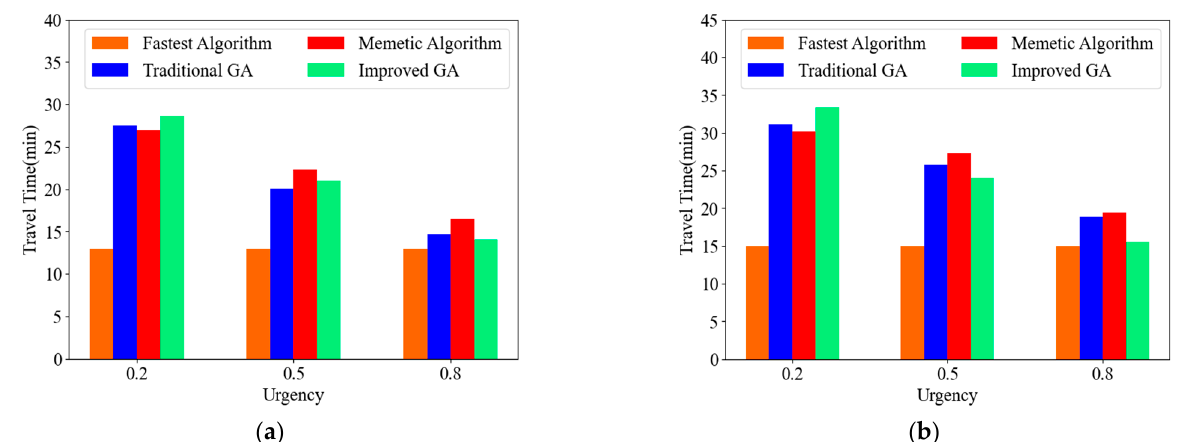
Figure 10. Comparison of route travel time under different urgencies. ( a ) Xi’an; ( b ) Wuhan.